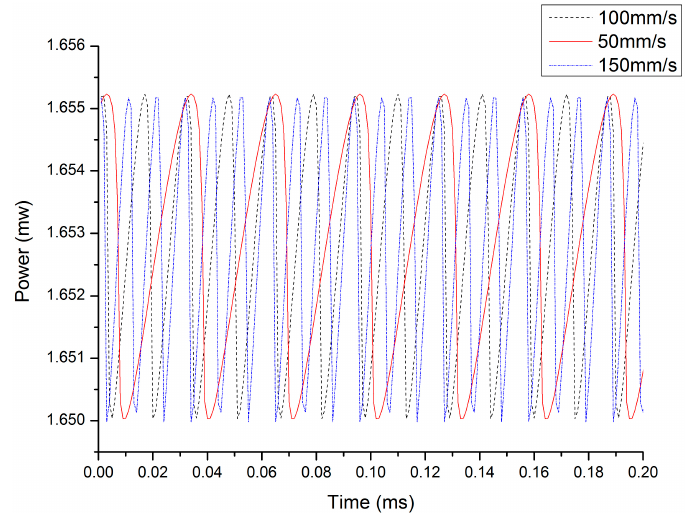
Figure 2. The simulated self-mixing output signals at different velocities.